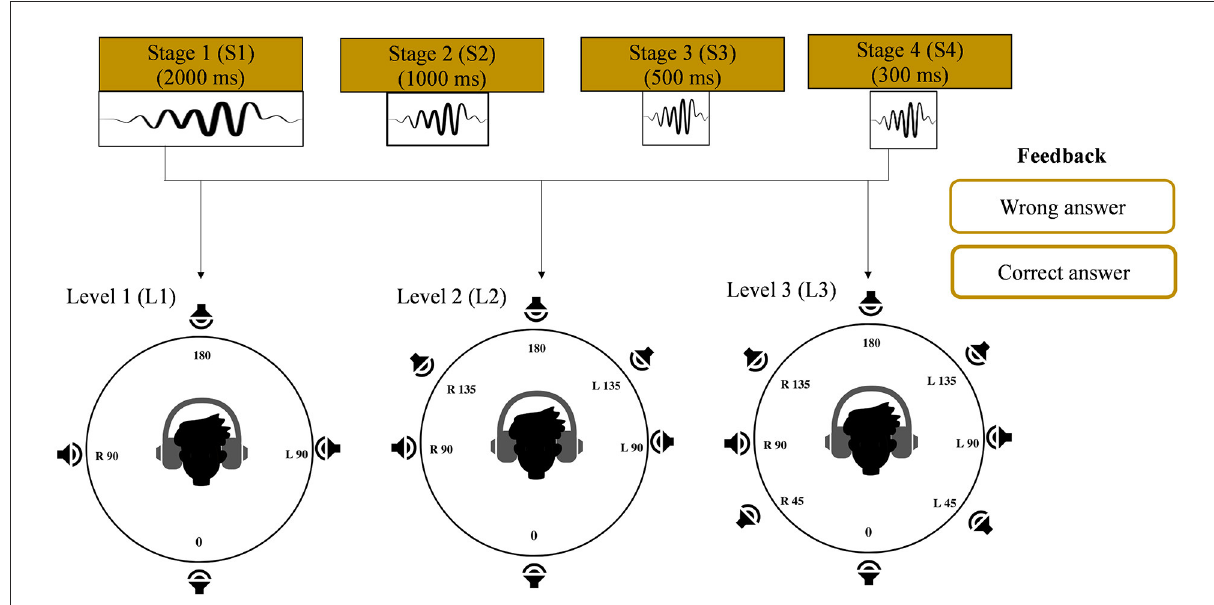
FIGURE3 Hierarchy of stimulus (duration and number of virtual locations parameters) presentation in the training phase of the study. Progression from left to right represents easy to difficult conditions. Feedback given during the training is also shown.